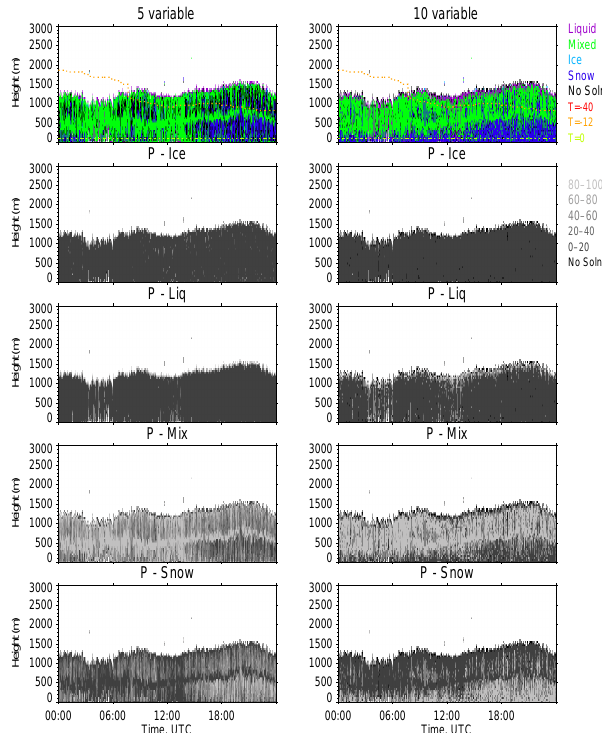
Figure 13. As in Fig. 10, but for 9 October 2004.